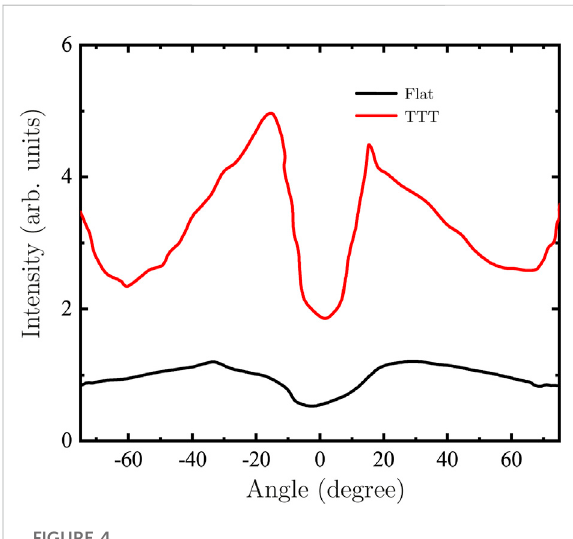
FIGURE 4 The angular-spectra distribution (accumulated and summed along the frequency axis in Figure 3) of THz radiation for both of the fl at target and